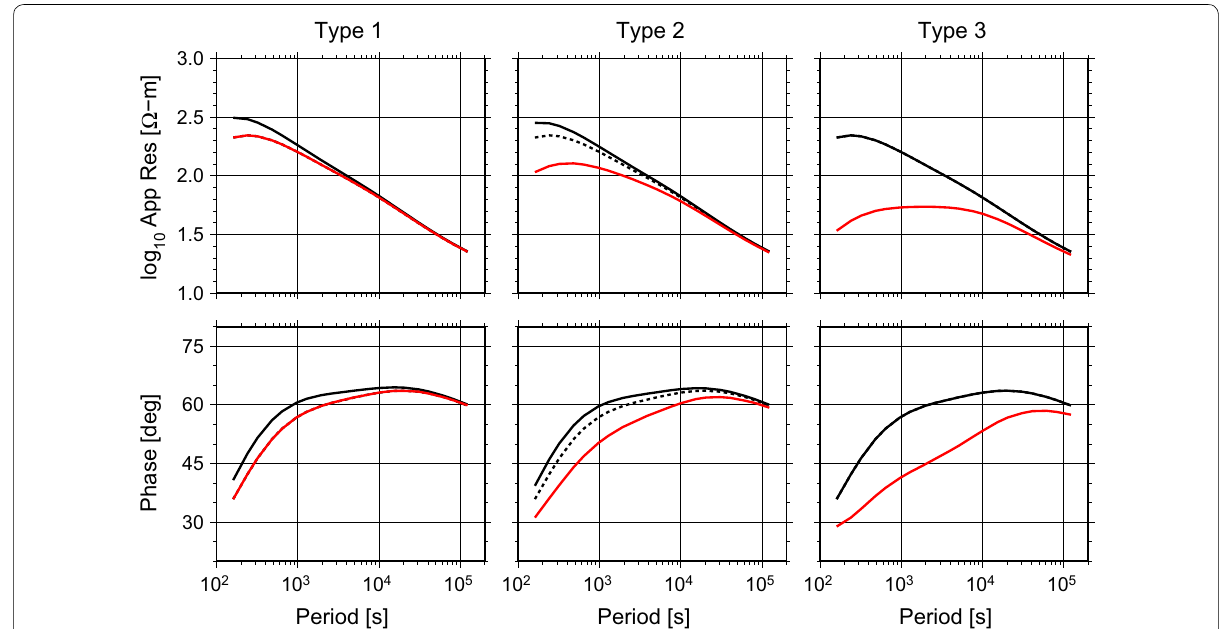
Fig. 2 Off-diagonal MT responses with splitting for three synthetic anisotropic models shown in Fig. 1. Red is most conductive element ( yx ), and black is least conductive element ( xy ). Dotted line in the type 2 plot shows responses of the isotropic 1D model of Sarafian et al.